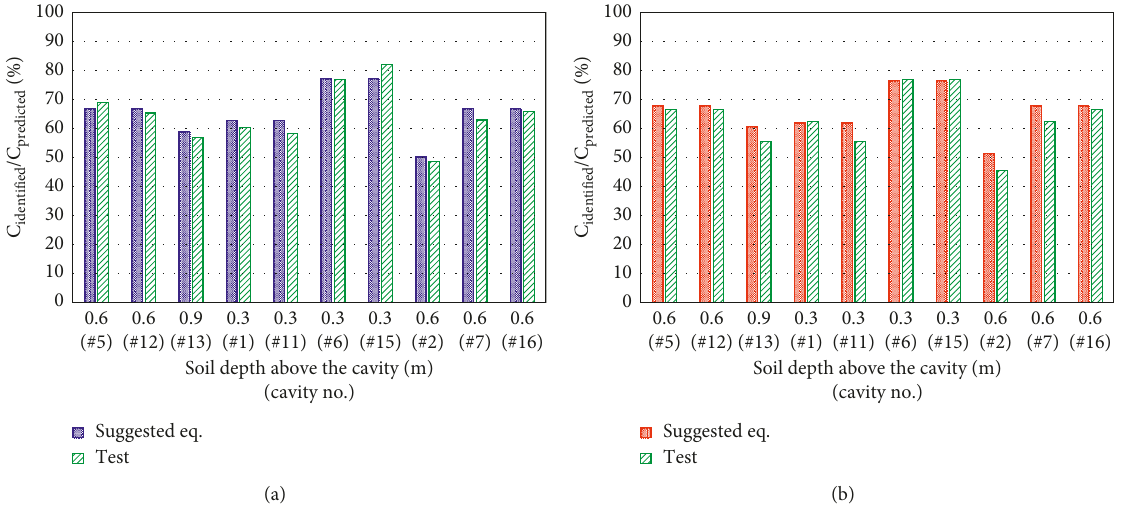
Figure 14: Evaluation results by the applied evaluation method. (a) Longitudinal section. (b) Cross